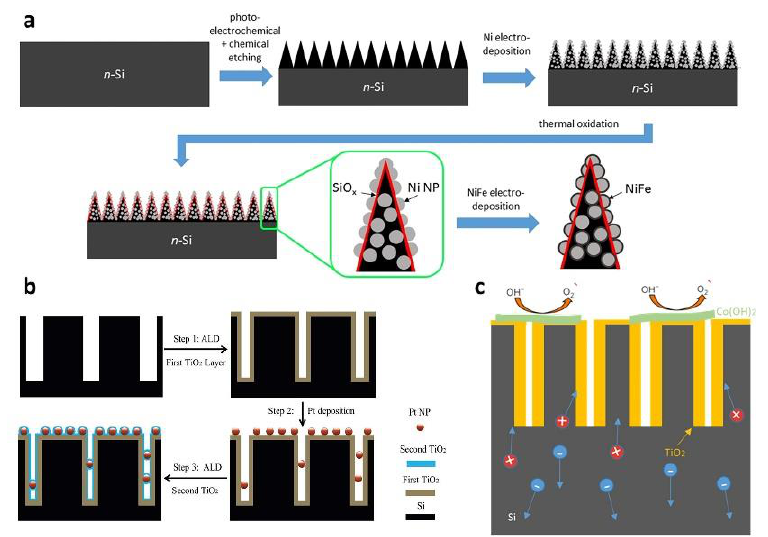
Figure 9. The applications of black silicon in photocatalysis and photo-electrocatalysis. ( a ) The fabrication process of NiNPs and SiO x on the black silicon surface. ( b ) The fabrication process of double TiO 2 protective layers with Pt nanoparticles on black silicon. Adapted from reference [26], with permission from Royal Society of Chemistry © 2020. ( c ) Schematic illustration of the charge generation and oxygen evolution processes in b-Si/TiO 2 /Co (OH) 2 .